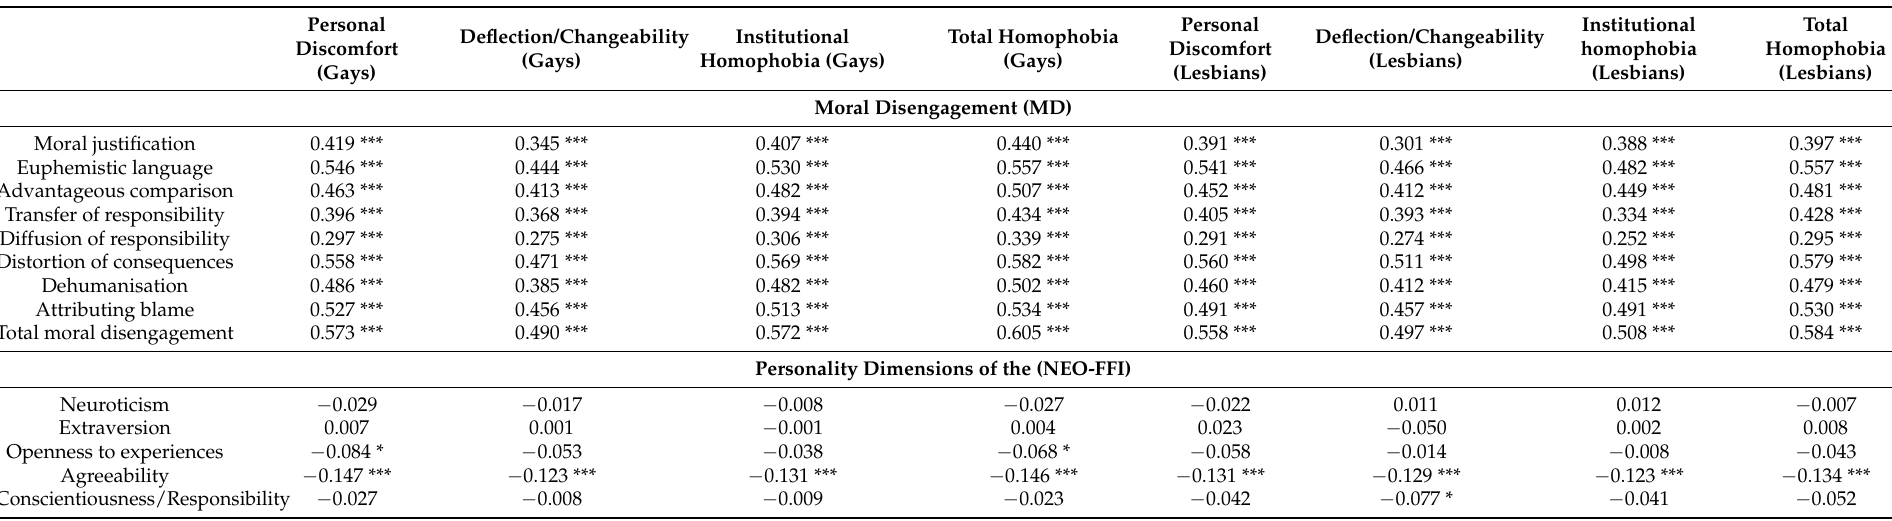
Table 2. Correlation analysis between moral disengagement, personality dimensions, and modern homophobia.